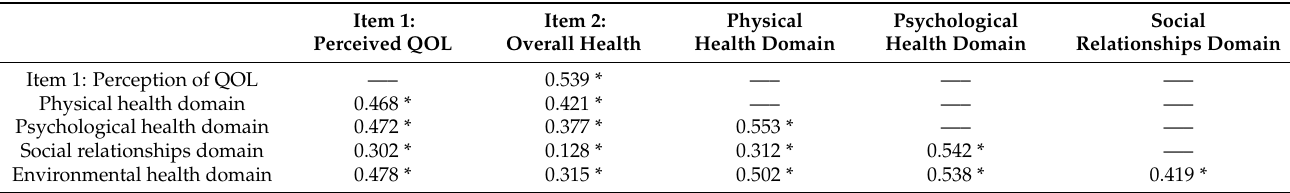
Physical Psychological Social Health Domain Health Domain Relationships